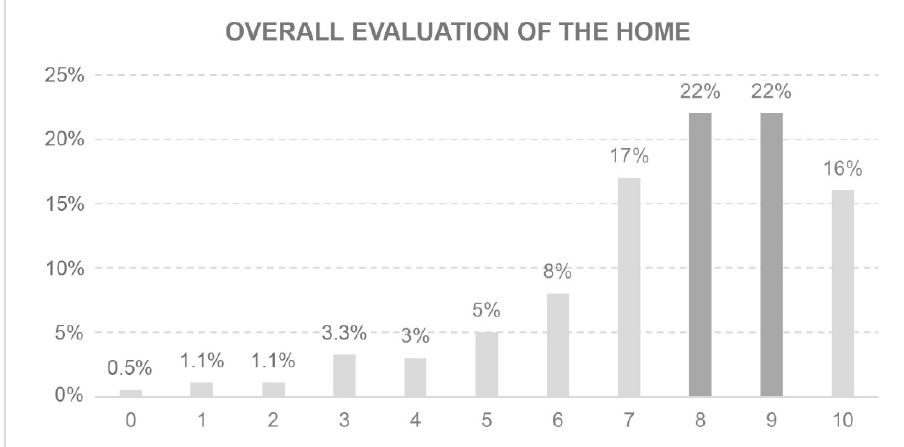
Figure 7. Overall evaluation of the home.